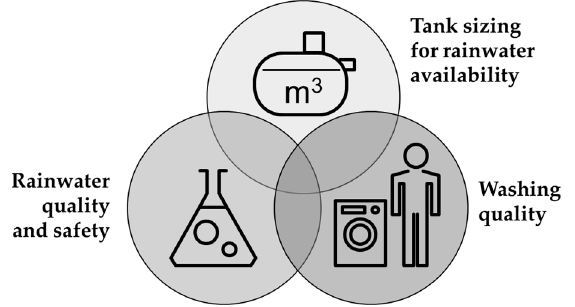
Figure 2. Three factors of stored rainwater suitability for washing purposes.